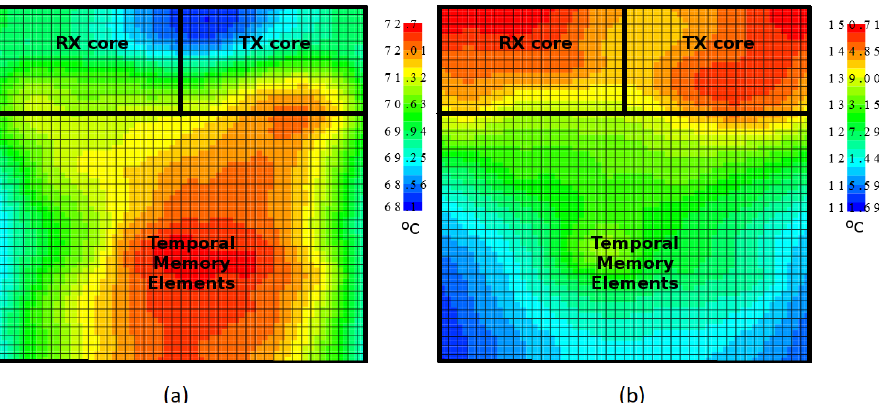
Figure 6. Thermal maps for ( a ) LP operating mode and ( b ) HP operating